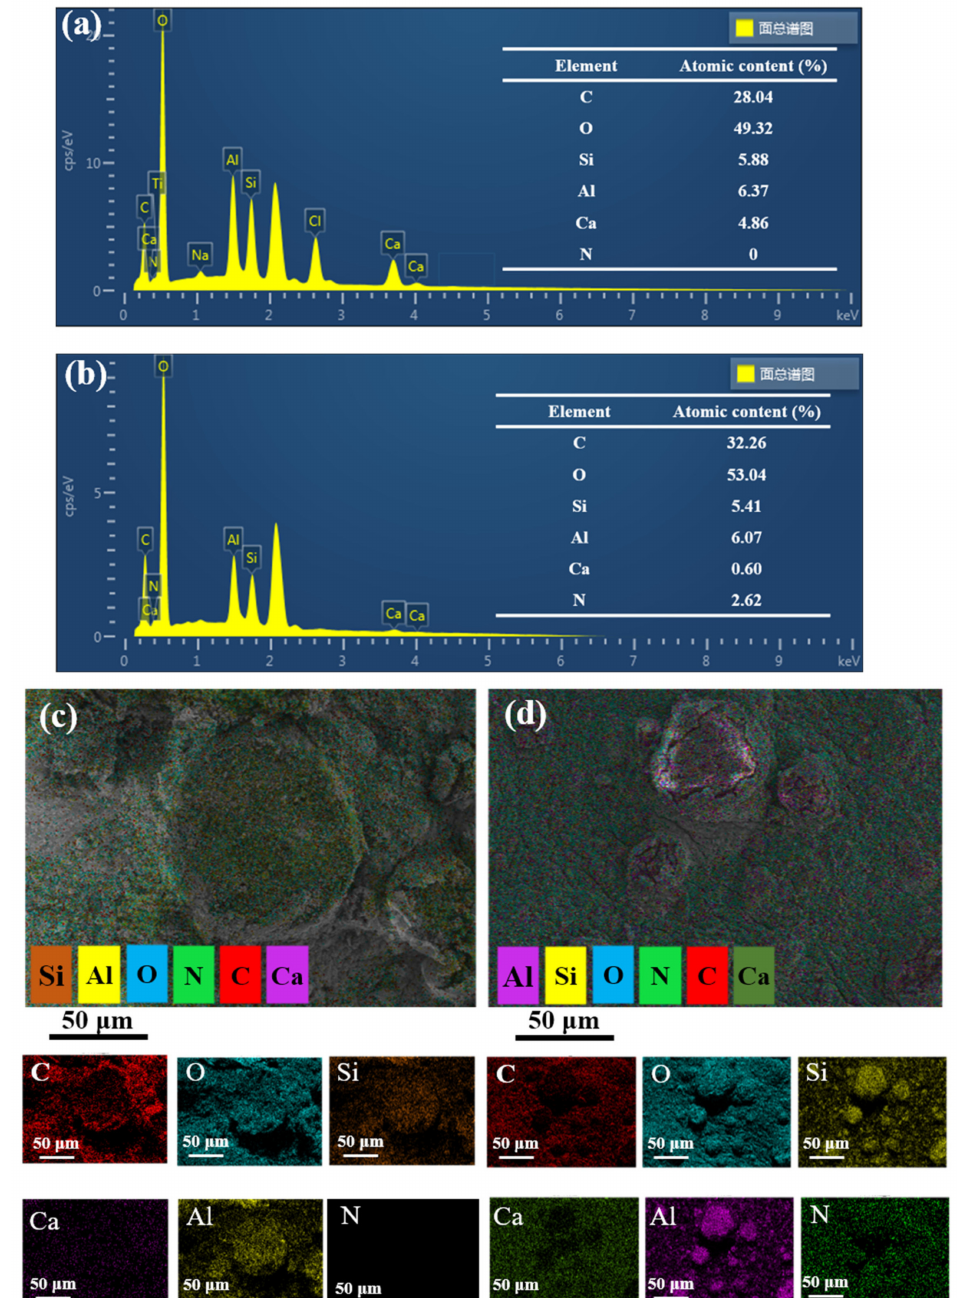
Figure2. Theelementalcompositionanalysis(EDS)( a , b )andelementalmappingspectraofCA-Al-KABs ( c ), Post-CA-Al-KABs ( d